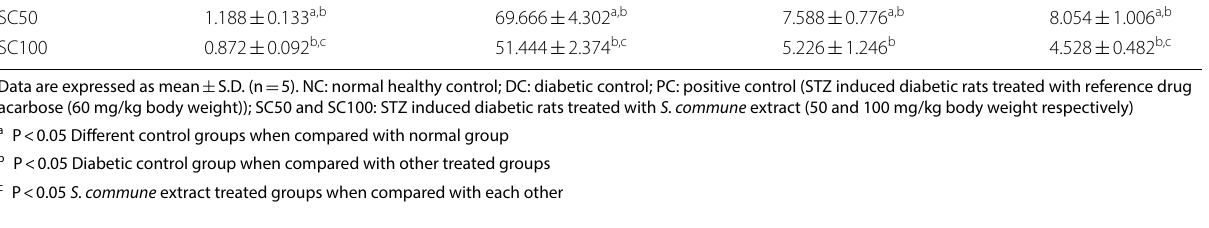
Table 2 Effect of S. commune extract on creatinine, BUN, FeNa, and potassium level in STZ induced diabetic rats Groups Creatinine (mg/dl)